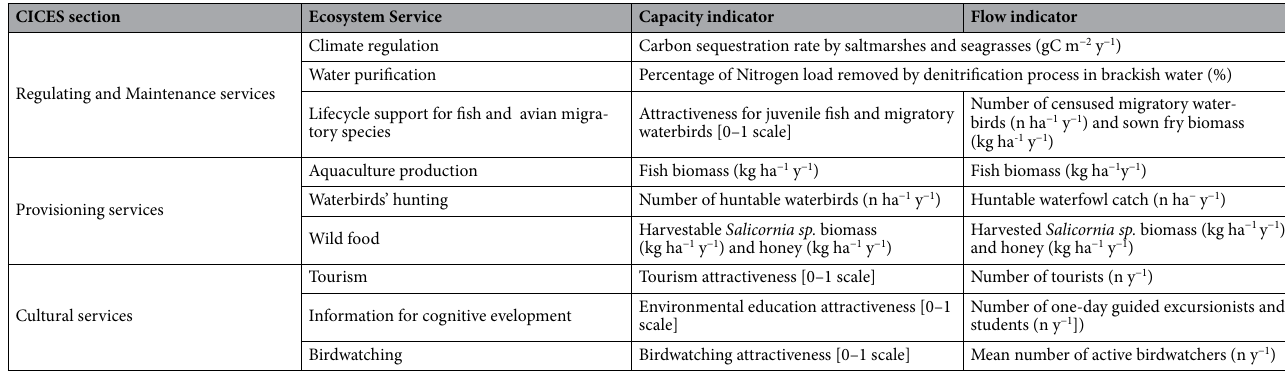
Table 2. Ecosystem services indicators applied in the